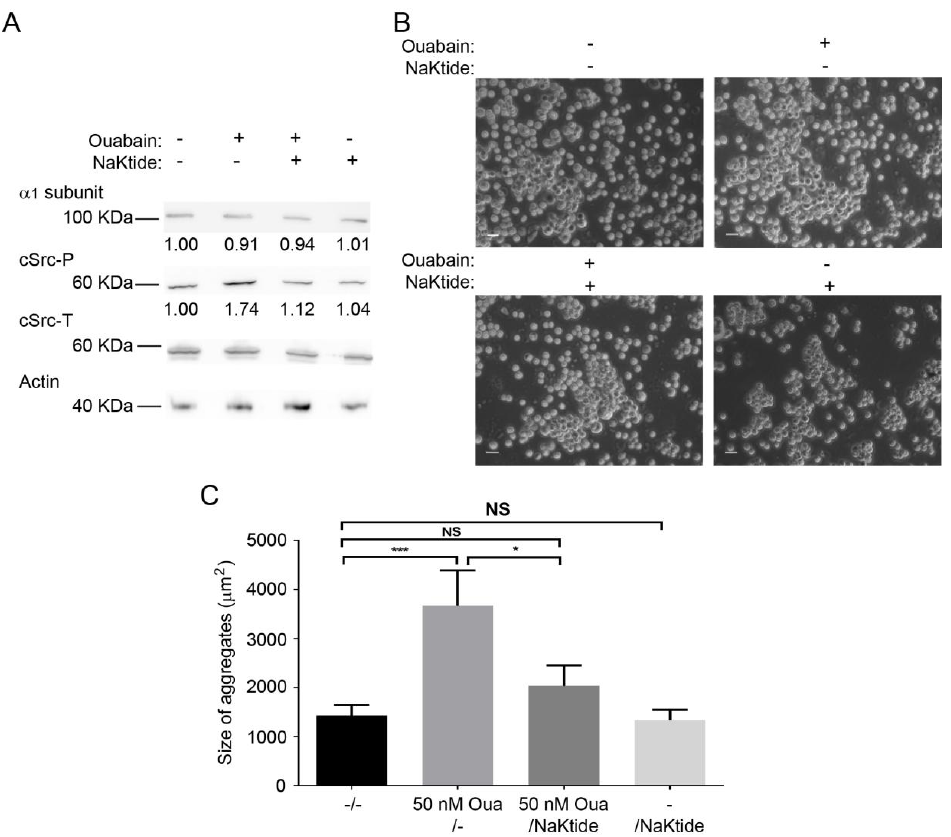
Figure 6. pNaKtide inhibits Ouabain-activated cSrc and ouabain enhanced β 1 -mediated cell adhesion in CHO β 1 cells. ( A ) Representative Western blot of cSrc activation (cSrcP), total cSrc (cSrcT), and α 1 subunits of CHO β 1 cells treated with (+) or without (-) 50 nM ouabain and 1 µM pNaKtide for 24 h ( n = 3). Actin was used as loading control. ( B ) Representative microscopy images of the dispase assay of CHOβ 1 cells treated with (+) or without (-) 50 nM ouabain and 1 µM pNaKtide n for 24 h; scale bar = 20 μm. ( C ) Quantification of the size of cellular aggregates of CHO β 1 control non-treated cells (-/-), and CHO β 1 cells cultured with (+) or without (-) 50 nM ouabain and 1 µM pNaKtide. The data represent the mean of three independent biological replicates ± SE. Kruskal Wallis and Dunn´s test for multiple comparisons were performed. NS non-significant, * p < 0.05, *** p < 0.0001.